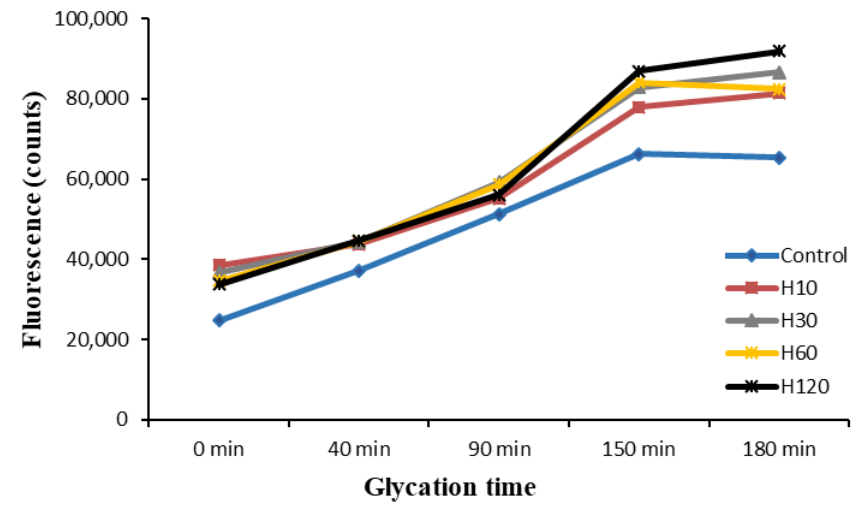
Figure 2. Fluorescence of the samples along Maillard glycation.